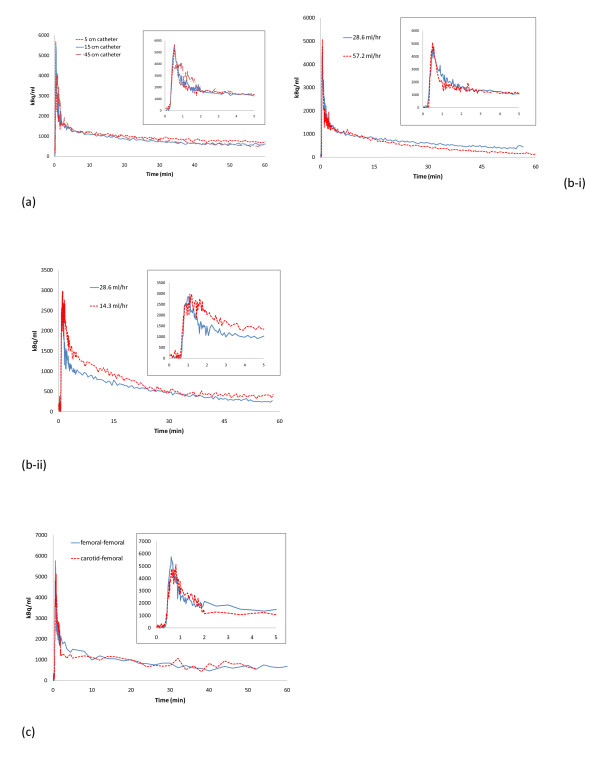
Shunt length, flow rate, and arterial source. (a) Effect of shunt length on dispersion of the input function peak (first 5 min shown). Data aligned for start of peak and corrected for injected activity for comparison purposes. (b) Effect of shunt flow rate on input function shape. (i) Effect of increasing pump speed (inset: first 5 min); (ii) Effect of reducing pump speed (inset: first 5 min). Data aligned for start of peak and injected activity for comparison urposes. (c) Comparison of input functions derived from femoral artery-femoral vein shunt to carotid artery-femoral vein shunt (first 5 min shown). Data from two individual subjects. Data aligned for start of peak and corrected for injected activity for comparison purposes.